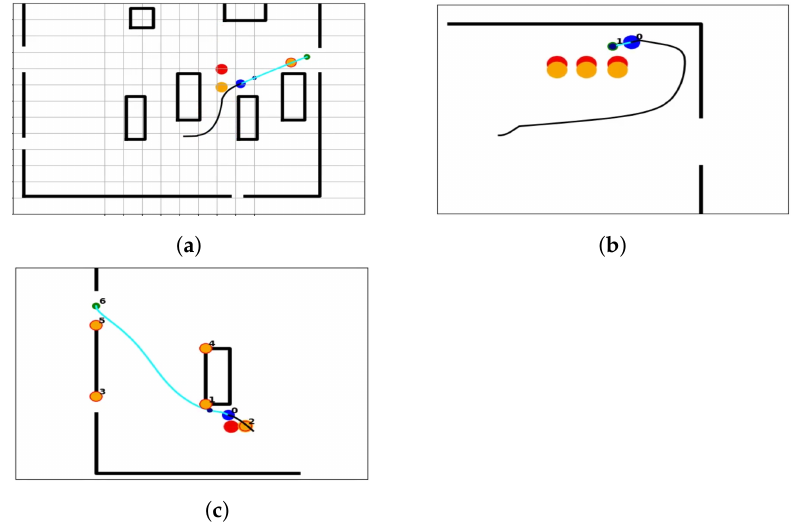
Figure 9. How various collisions are prevented using the adapted Bezier curve algorithm from Section 5. ( a ) Resolving a collision inside a tight, fixed-width corridor; ( b ) resolving a lateral collision in Stage 9; ( c ) resolving a frontal collision in Stage